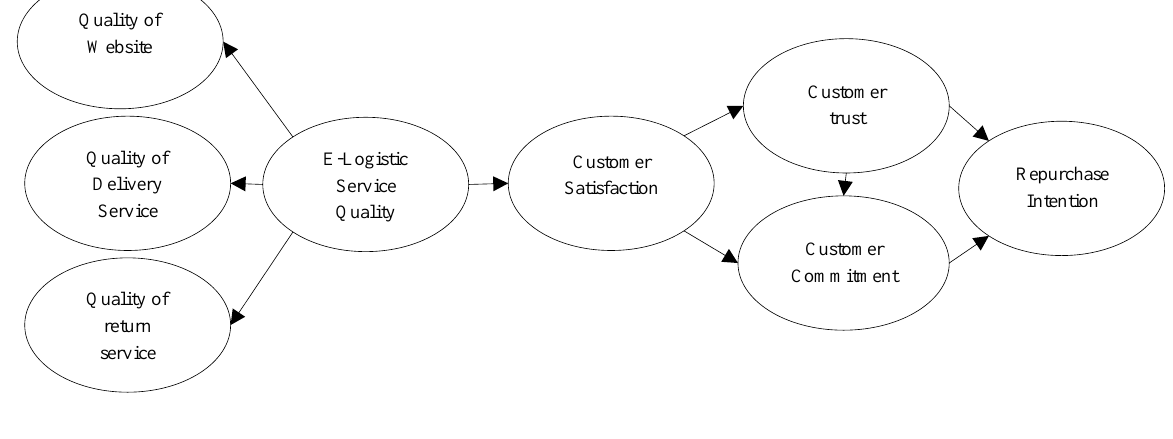
Figure 1: Research Model - Conceptual framework of the